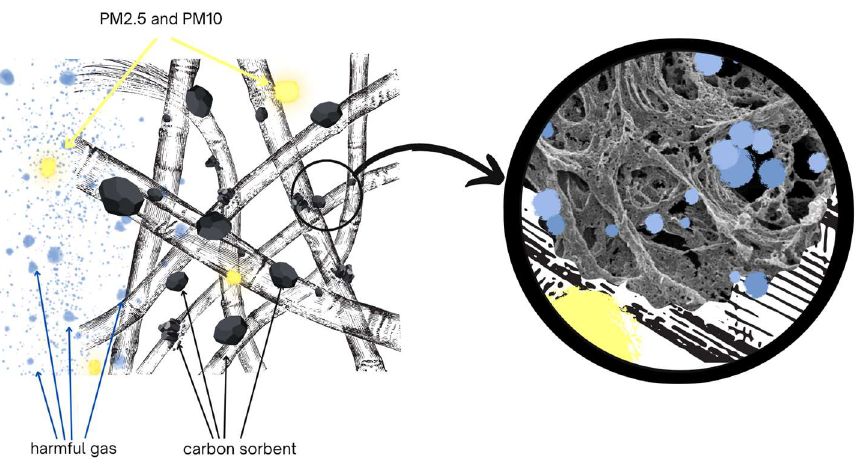
Figure 1. Mechanism of capturing pollutants by an anti-smog mask.